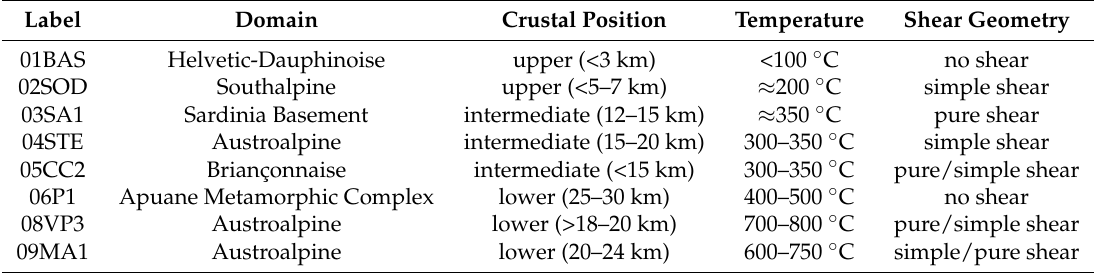
Table 1. List of samples labels with Alpine geological domain, crustal position with depth in km, temperature in ◦ C and shear geometry. Labels are the same as used in Figures and text. See text for references on P, T and shear geometry. Upper crust for depth < 10 km at T < 300 ◦ C, intermediate crust for depth between 10 and 20 km and T between 300 and 400 ◦ C, and lower crust for depth > 20 km and T > 400 ◦